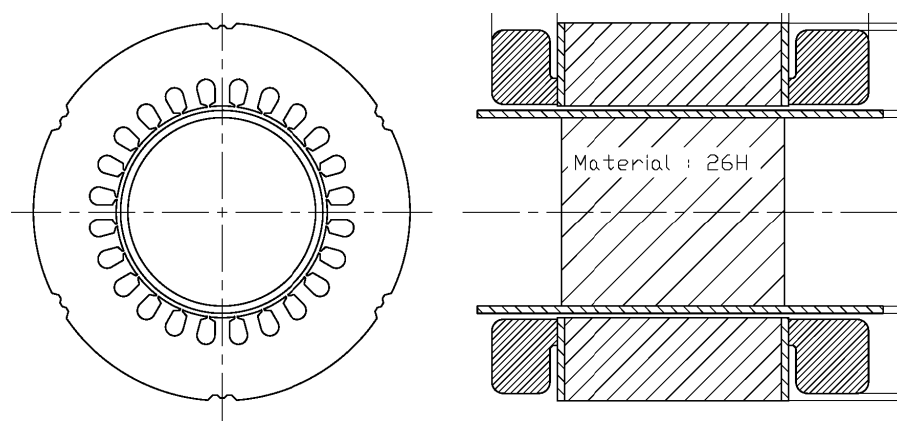
Figure 5. Three-phase winding distribution.